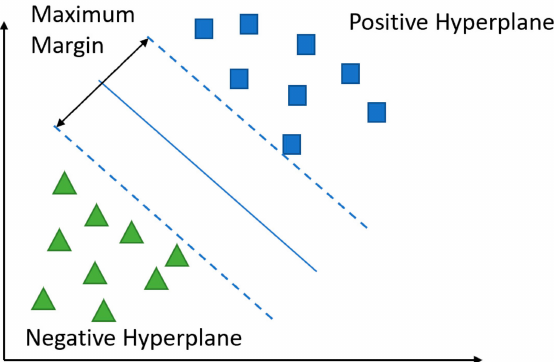
Figure 6. SVM positive and negative hyperplanes with the maximum margin.